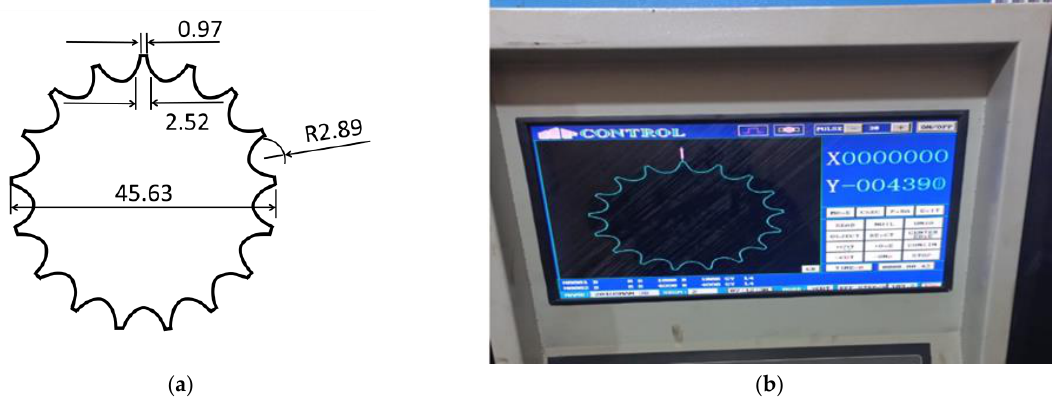
Figure 4. Wire cut electric discharge digital control machining showing ( a ) profile of timing chain sprocket gear teeth (all measurements in mm) and ( b ) the system working on a gear profile.